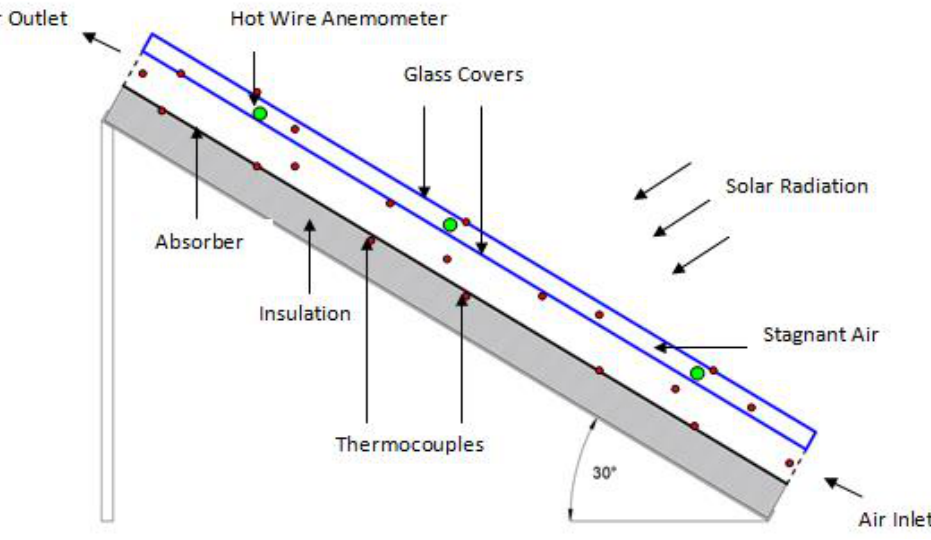
Figure 2. A schematic view of the Modified FPSAH, Case B.